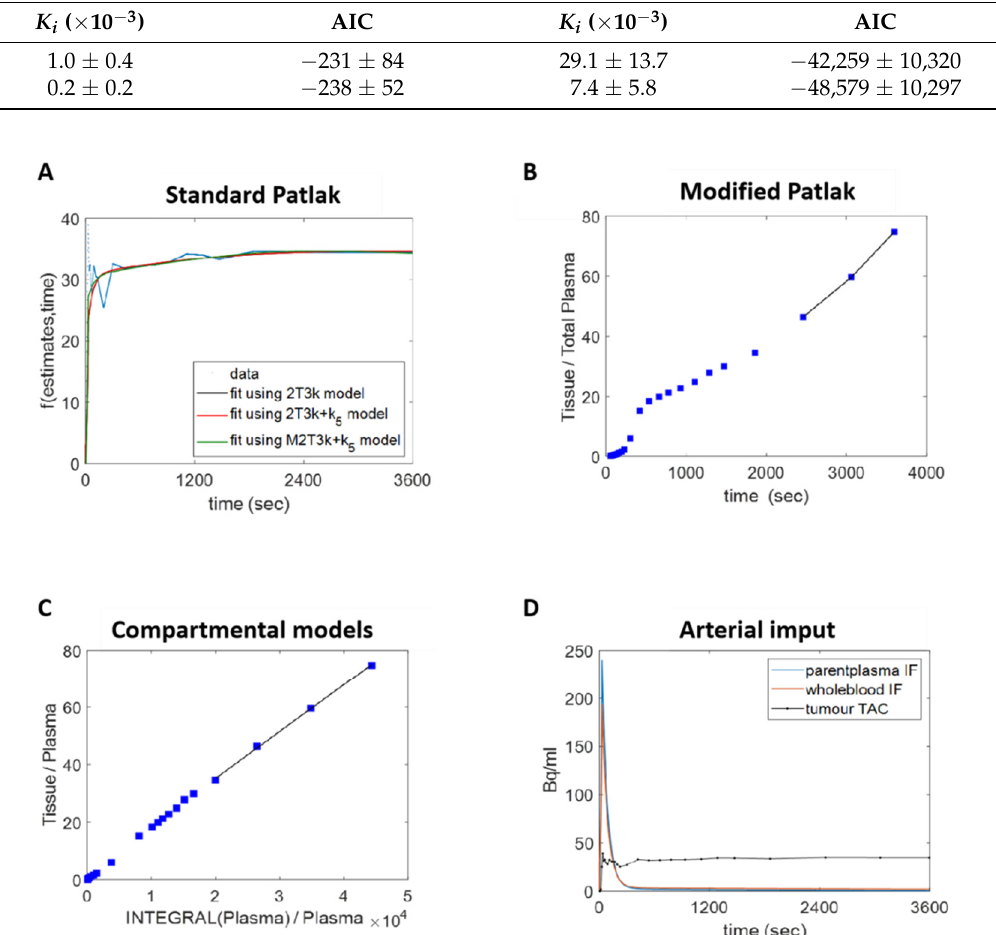
Figure 7. Dynamic PET data quantification. ( A ) The standard Patlak plot assumes the presence of an irreversible compartment and a time t* after which all the reversible compartments are in equilibrium with the plasma. This method provides the irreversible uptake rate constant K i , which is the slope of the regression line. With the same assumption of the standard one, ( B ) the modified Patlak plot takes into account the contribution of the metabolites to the exchangeable space within tissues and demands the use of an arterial plasma input function that is corrected for metabolites. The K i is evaluated as before. ( C ) A true quantification of the tracer exchange rates between the compartments can be obtained by fitting the patient data with compartmental models. The irreversible 2 tissue 3 k (2T3 k ), 2 tissue 3 k + k 5 (2T3 k + k 5 ), and the modified two-tissue 6 k + k 5 (M2T6 k + k 5 ) were used. ( D ) The kinetic analysis of the [ 18 F]-D4-FCH PET data demands the implementation of an arterial input function. Table 1. The results of the standard and modified Patlak plots.